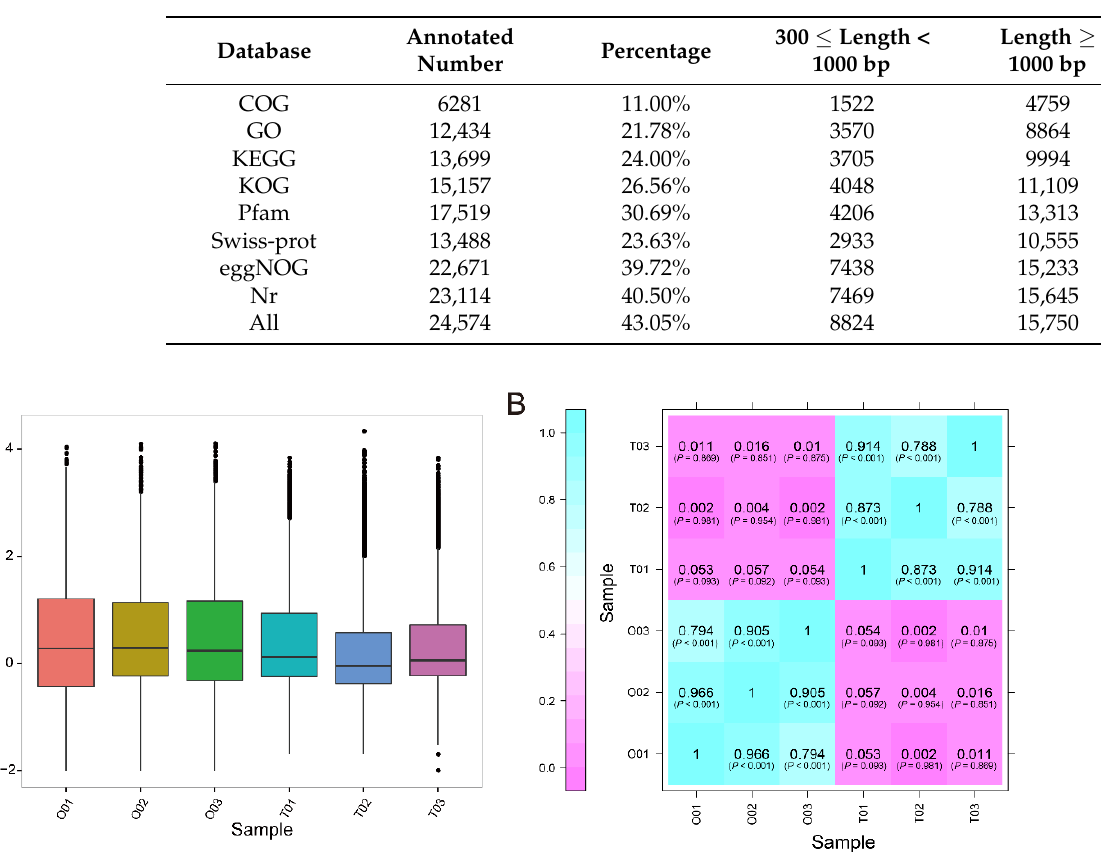
Table 3. Statistics of the D. hystrix gonadal transcriptome annotation.